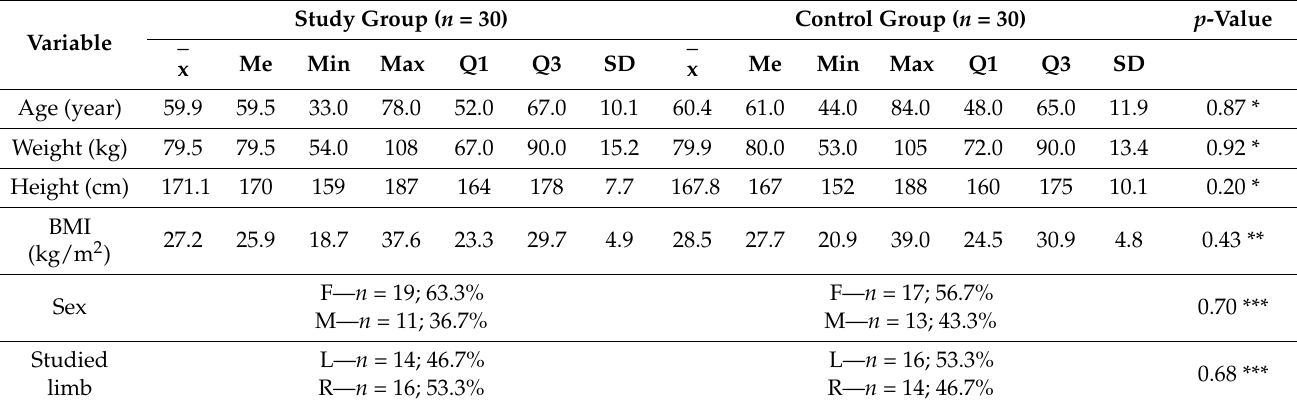
Table 1. Characteristics of the comparison